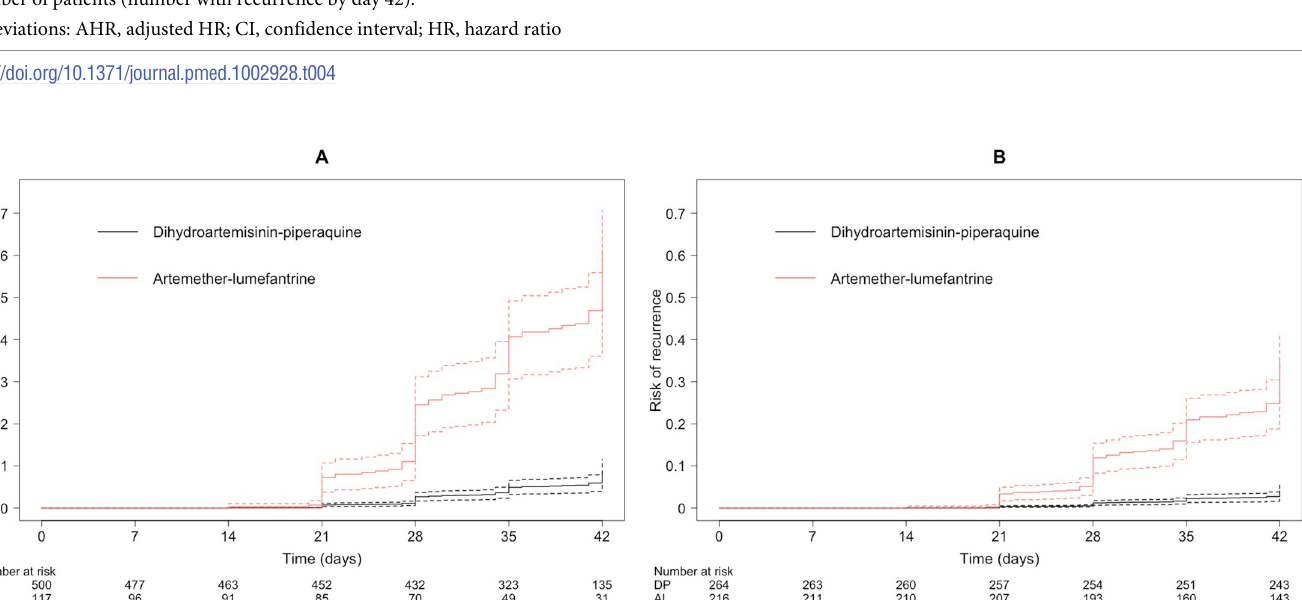
PLOS Medicine| https://doi.org/10.1371/journal.pmed.1002928 October 4,